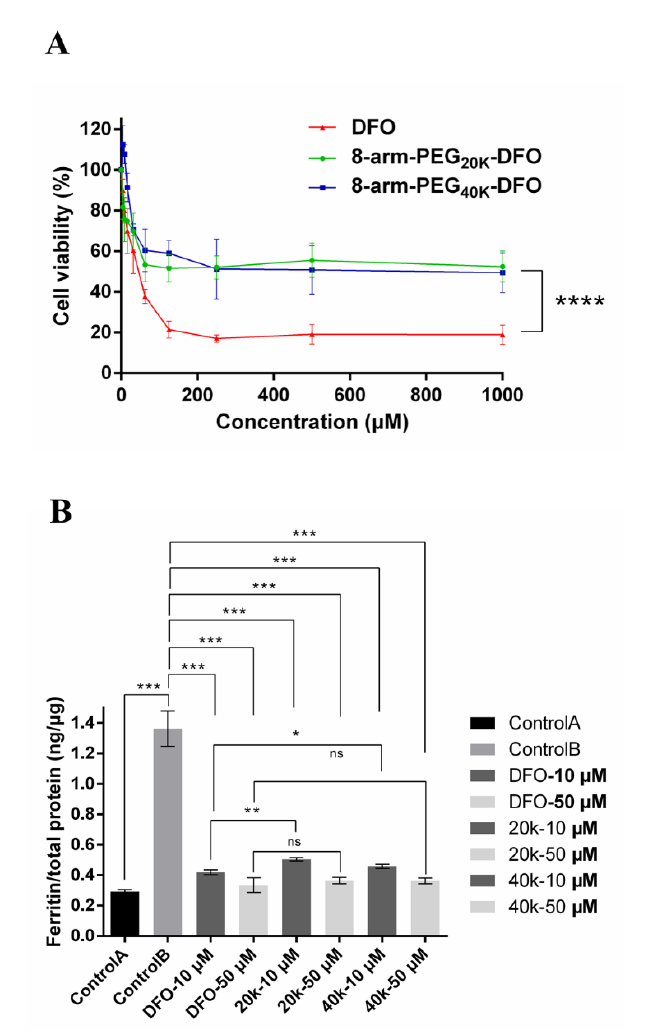
Figure 5. ( A ). In vitro cytotoxicity of DFO, 8-arm-PEG 20k -DFO, and 8-arm-PEG 40k -DFO upon the RAW 246.7 macrophage cells; ( B ). The ferritin reduction assay to monitor iron chelation e ffi cacy of DFO, 8-arm-PEG 20K -DFO, and 8-arm-PEG 40K -DFO in iron-overloaded RAW 246.7 macrophage cells; cells were treated with DFO or equivalent 8-arm-PEG-DFO conjugates at 10 or 50 µ M for 48 h. Cellular ferritin level was measured by the mouse ferritin ELISA assay. Results are normalized to total protein (ng / µ g). * P < 0.05, ** P < 0.01, *** P < 0.001, **** P <